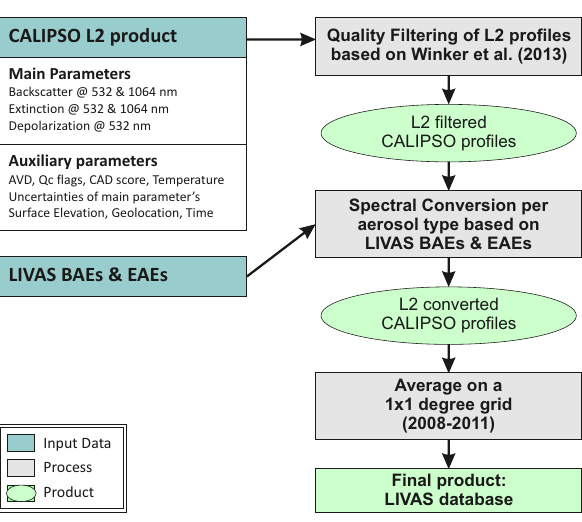
Figure 9. Schematic diagram of LIVAS processing